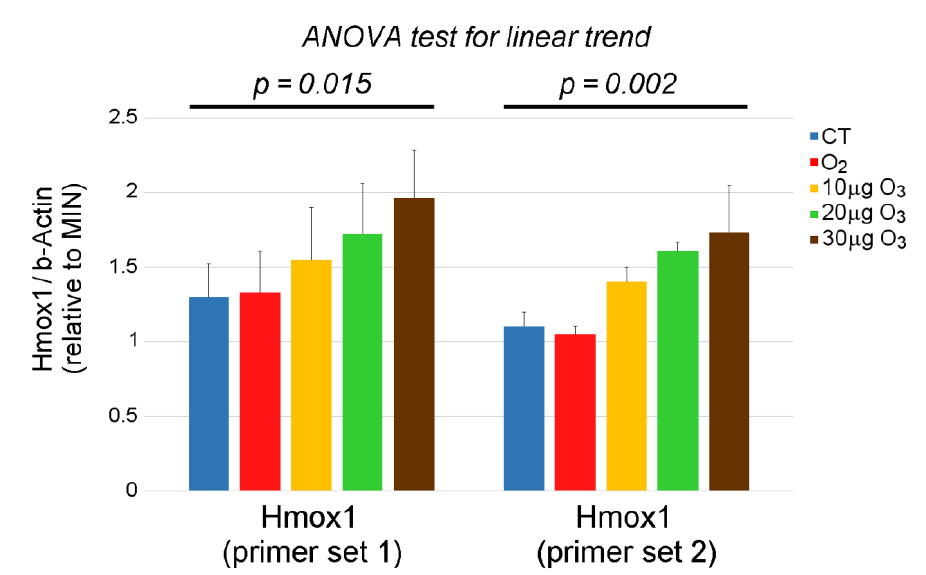
Figure 5. Gene expression of Hmox1 in Jurkat cells at 24 h post-treatment. CT: control.